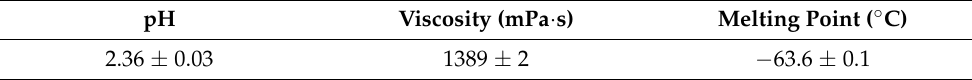
Table 1. Physical characteristics of sulfamic acid and glycerol DES at 25 ± 2 °C.